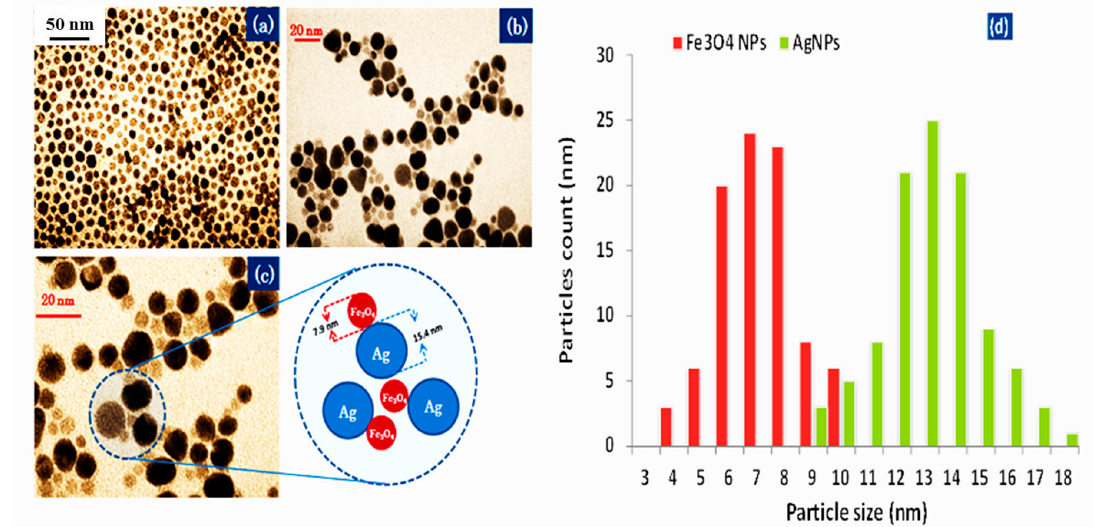
Figure 1. TEM images of oleic acid (OA)/oleylamine (OLA) coated Fe 3 O 4 NPs: ( a ) and FeAg NPs ( b , c ) dispersed in DBC and ( d ) the nanoparticle size distribution of Fe 3 O 4 nanoparticles and Ag NPs. The insert image in Figure 1c shows an illustration of hybrid nanoparticles.